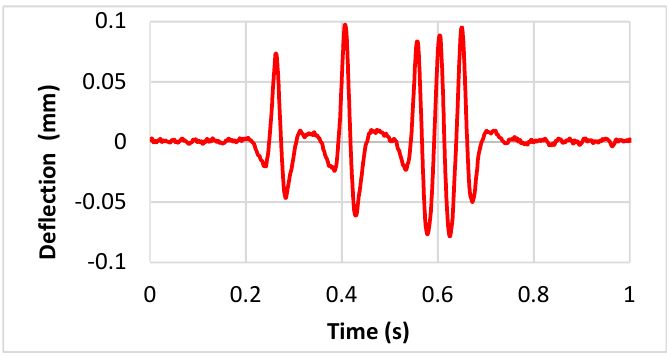
Figure 7. Geophone GS11D signal after integration process.